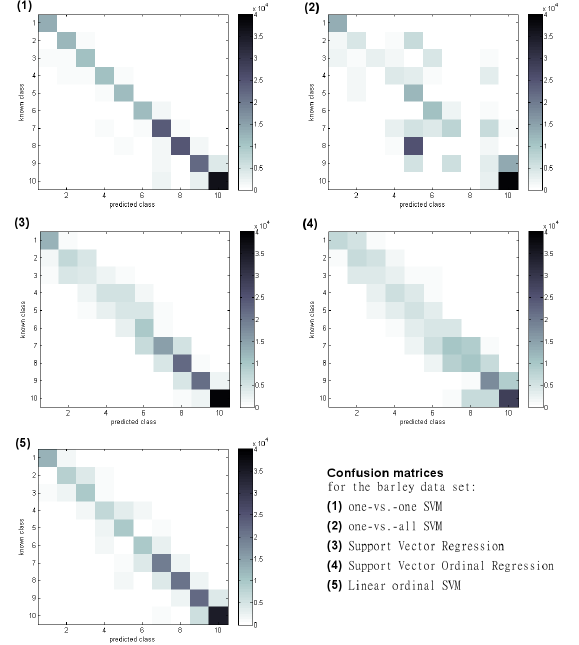
Figure 11: Confusion matrices for the described barley data set. The prediction algorithms can be separated in two groups: a good accuracy is achieved by the on-vs.-one SVM (83%), the SVR (66%) and the Linear Ordinal SVM (70%); an inferior accuracy is achieved by the on-vs.-all SVM (46%) and the Support Vector Ordinal Regression